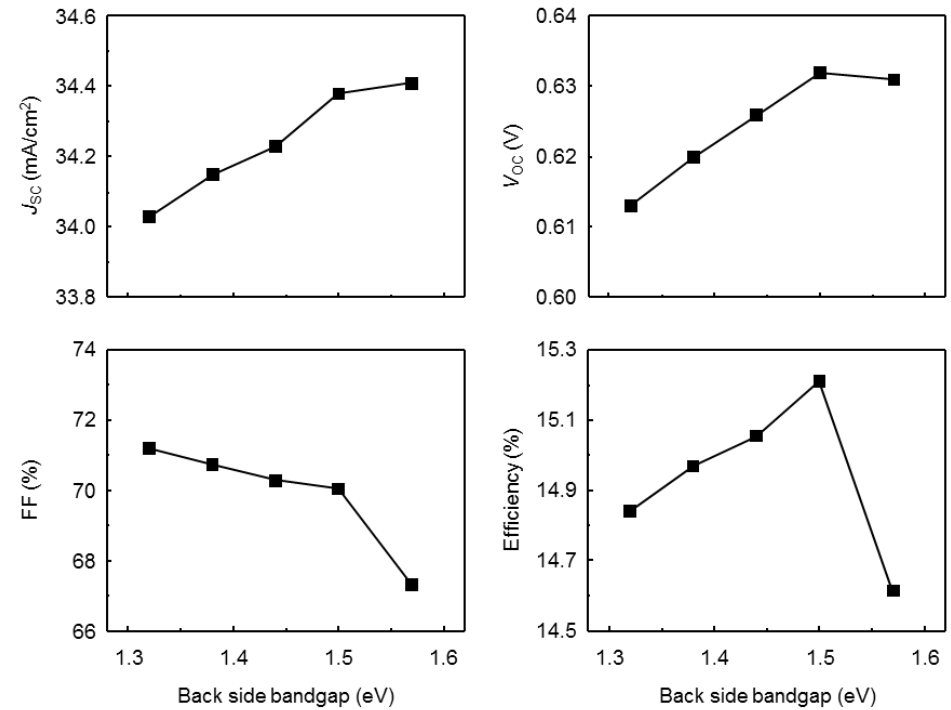
Figure 5. Simulated solar cell conversion efficiency at the position in CIGS cell as a function of the back side bandgap: J SC , V OC , FF, Efficiency of CIGS solar cell with ZnS buffer layer as a function of back side bandgap.